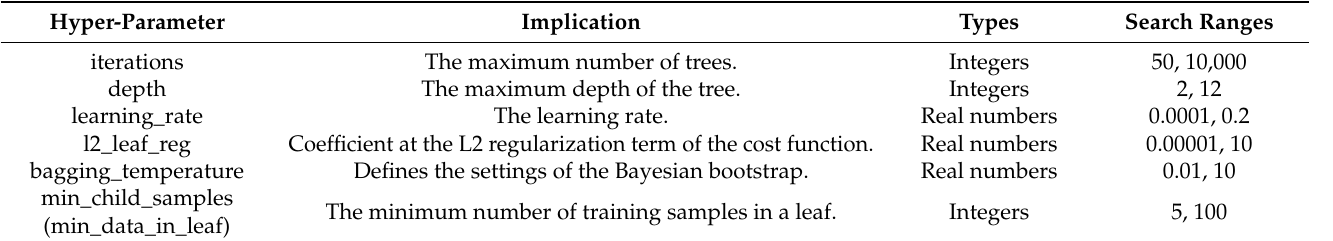
Table 7. Hyperparameters of the CatBoost model tuned in this study